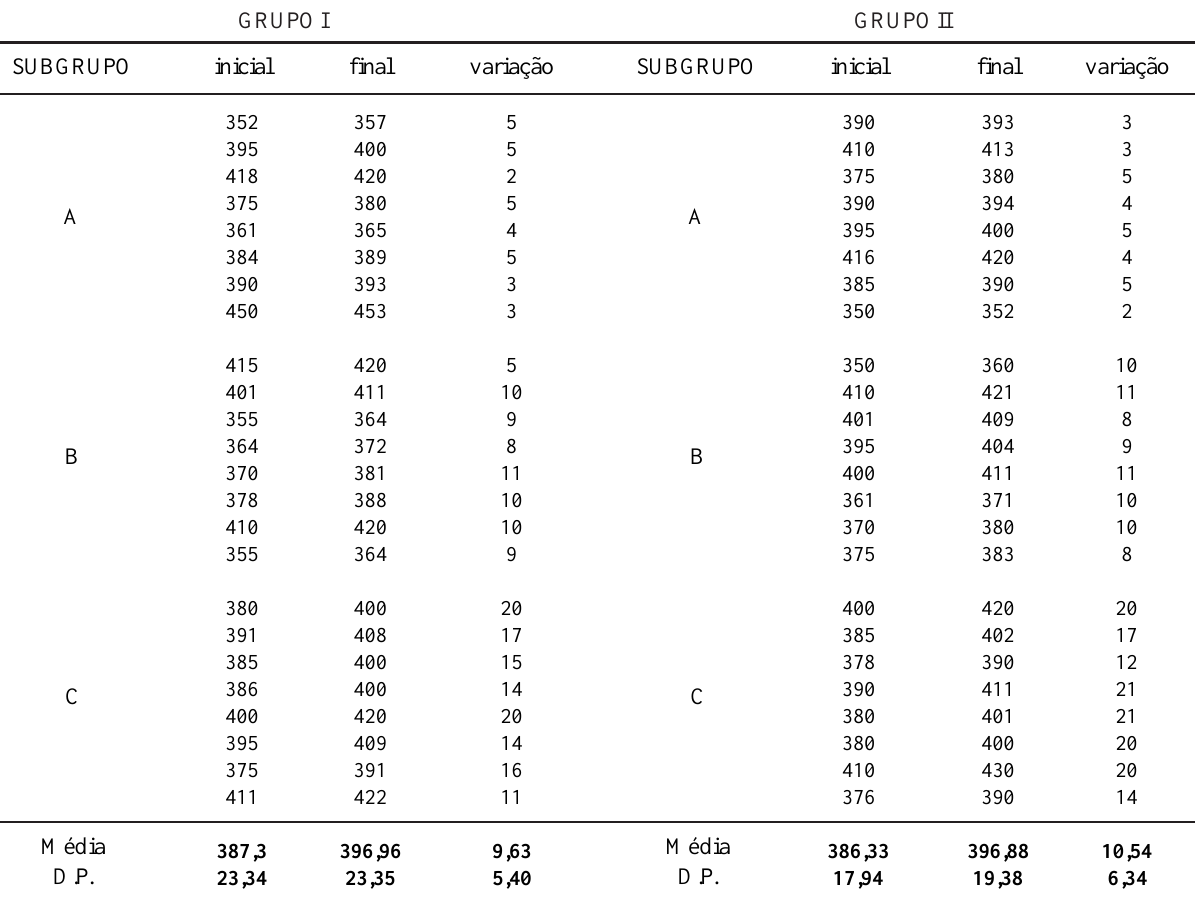
TABELA 1 - Peso Animais dos grupos I e II com respectivos subgrupos A, B e C, segundo o peso inicial e final